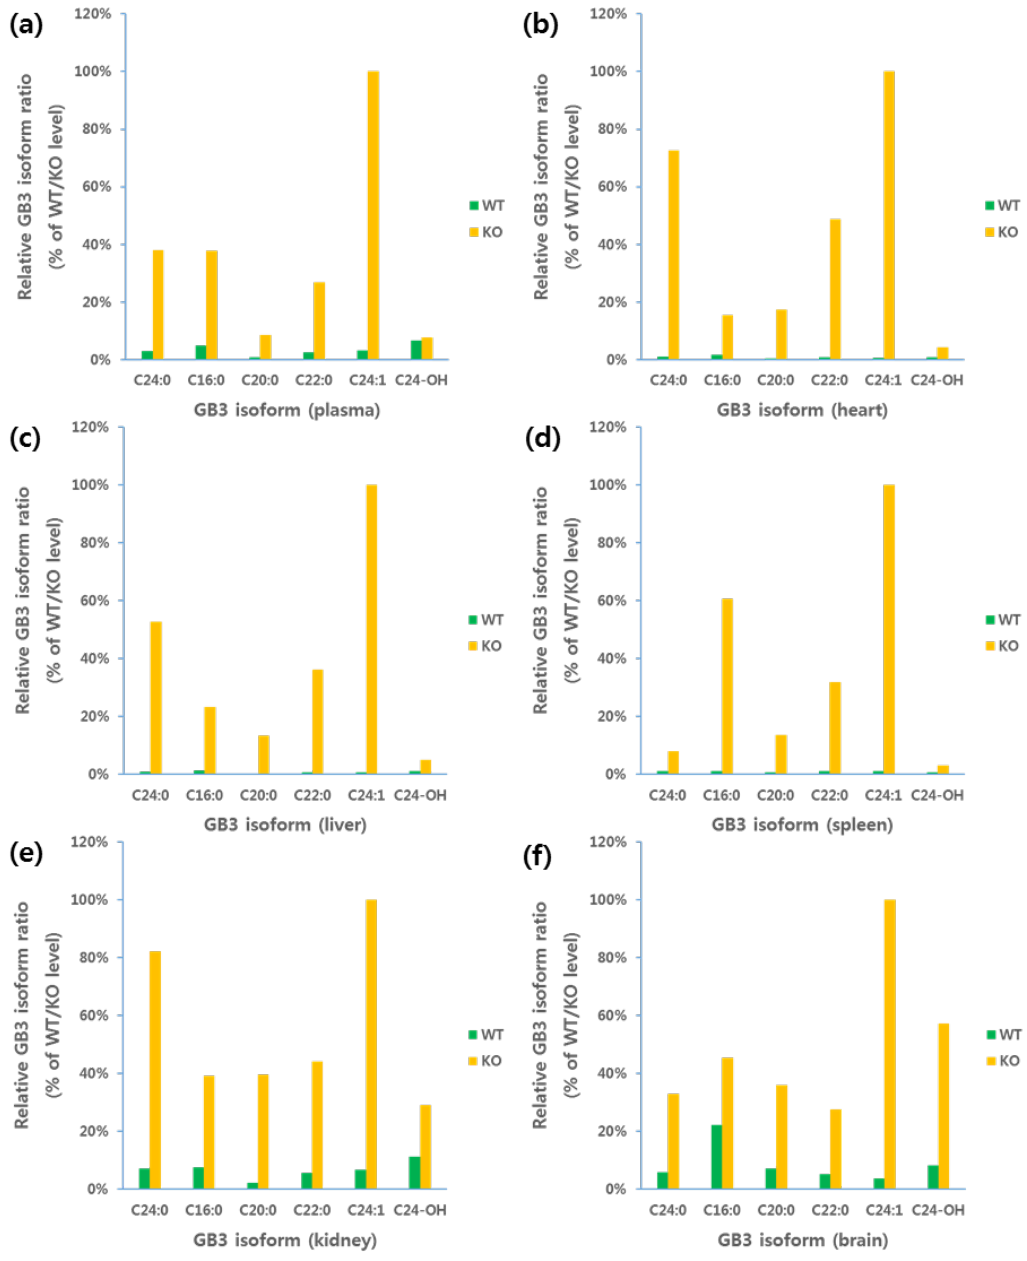
Figure 6. Relative GB3 isoform ratio in plasma and each of the tissues: ( a ) plasma; ( b ) heart; ( c ) liver; ( d ) spleen; ( e ) kidney; and ( f ) brain.